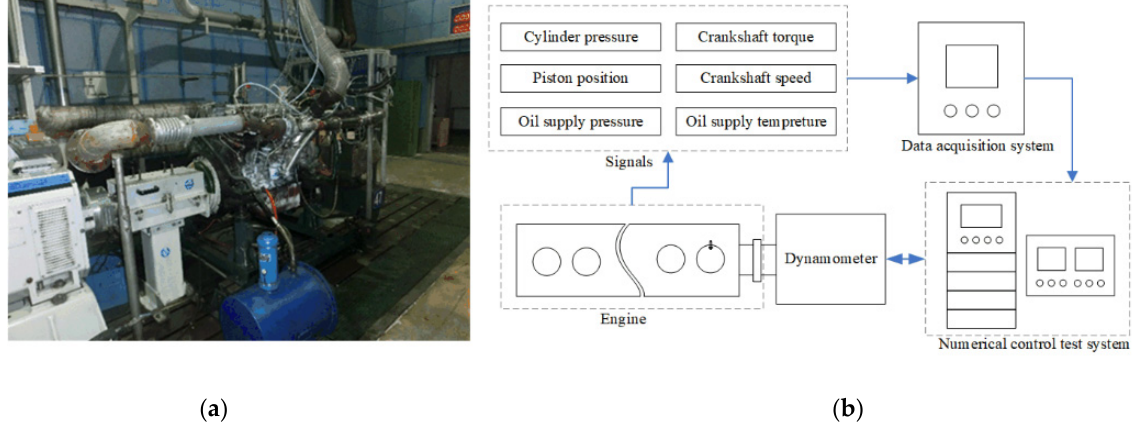
Figure 2. The arrangement of the experimental system: ( a ) test bench in the lab; ( b ) diagram of the experimental system. A dynamometer is connected to the rear end of the engine; signals of the cylinder pressure, the piston top dead point position, the oil supply pressure, the rotational speed and torque of the crankshaft are transmitted to the data acquisition system, and the test bench are manipulated by a numerical control test system. The properties of the devices are shown in Table 2. Table 2. Properties of the devices.